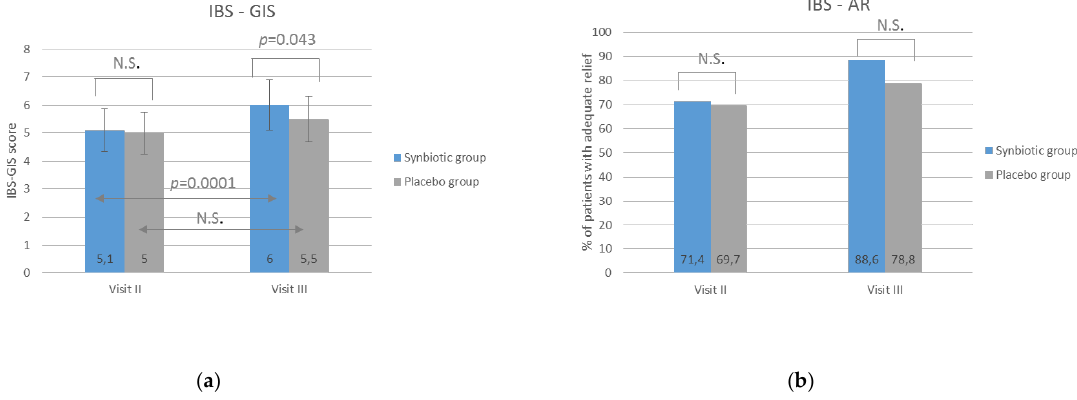
Figure 3. The impact of synbiotic treatment on the global improvement of IBS-symptoms (IBS-GIS) ( a ) and adequate relief (IBS-AR) ( b ). IBS-GIS and IBS-AR were evaluated after 4 weeks (visit II) and 8 weeks (visit III) of treatment. The results are presented as means of IBS-GIS score or the percentage of patients with adequate relief. A statistically significant improvement of IBS-GIS score between visits II and III was observed only in the synbiotic group, and a significantly amelioration in the synbiotic group compared with the placebo group was found after 8-week lasting treatment (visit III). No statistically significant di ff erences were found in IBS-AR. N.S. = no significance ( p > Table 5. The effect of synbiotic treatment on the global improvement of IBS symptoms. Probiotic Group ( n = 35) Placebo Group ( n = 33) p -Value OR No No Improvement Improvement Improvement Improvement Visit II